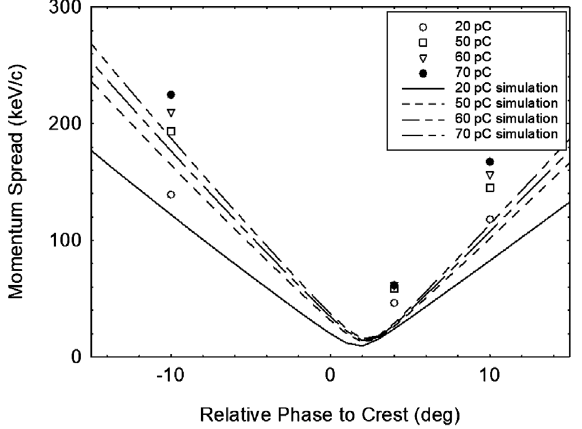
FIG. 36. Momentum spread versus rf phase for various bunch